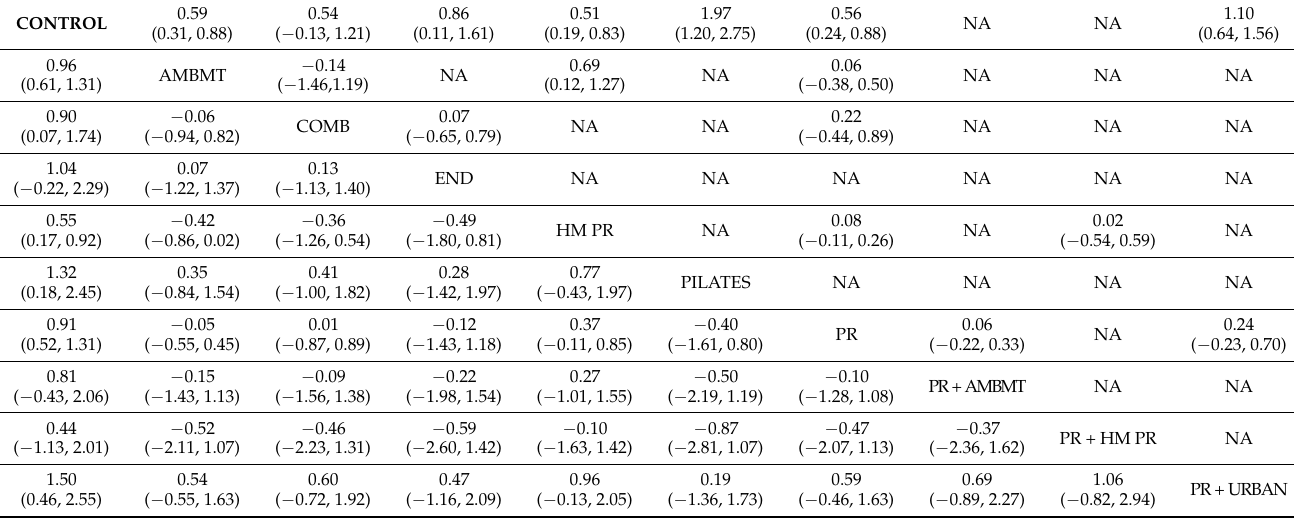
Table 3. Pooled mean differences of physical activity on 6 MWT. Upper right triangle provides the pooled mean differences from pairwise comparisons (column intervention relative to row), lower left triangle pooled mean differences from the network meta-analysis (row intervention relative to